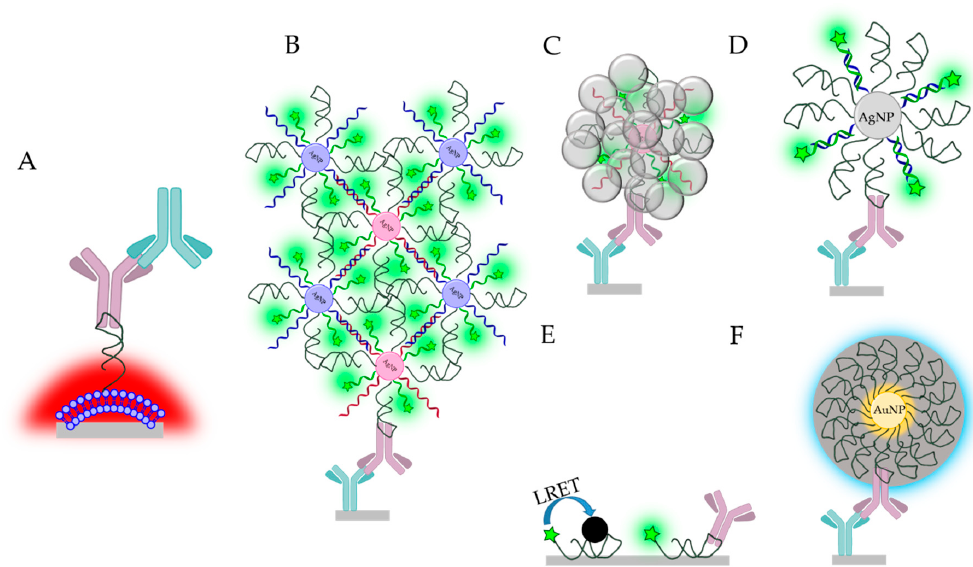
Figure 8. Heterogeneous fluorescence and luminescence detection-based assays [121–126] using colorimetric transition of liposomes ( A ), metal-enhanced fluorescent detection with hybrid probes ( B ), silver nanostructures ( C ) and fluorescent probes ( D ), luminescent resonance energy transfer between